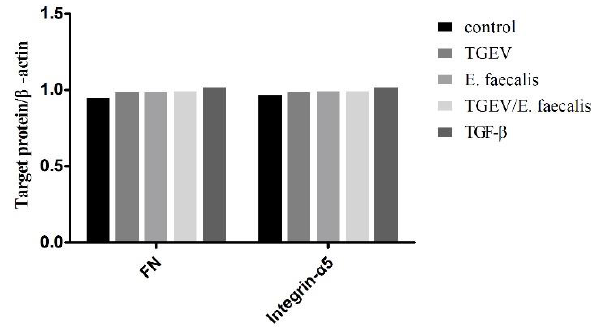
Figure A5. Gray analysis of western blot in Figure 11.